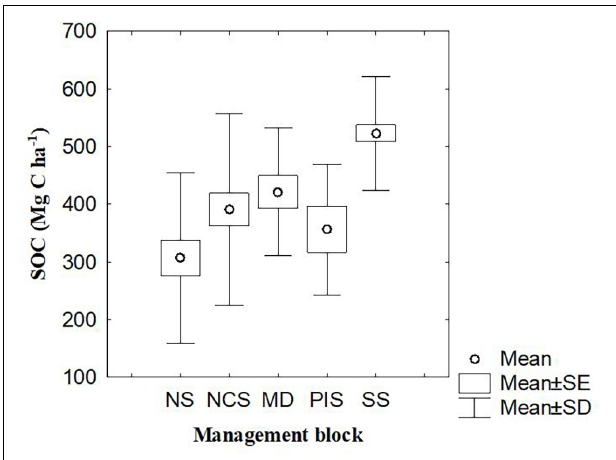
FIGURE 6 | Soil organic carbon (SOC) in different mangrove management blocks of Lamu. MD, Mongoni and Dodori Creek swamps, NS, Northern swamps, NCS, Northern Central swamps, PIS, Pate Island swamps, and SS, Southern swamps.